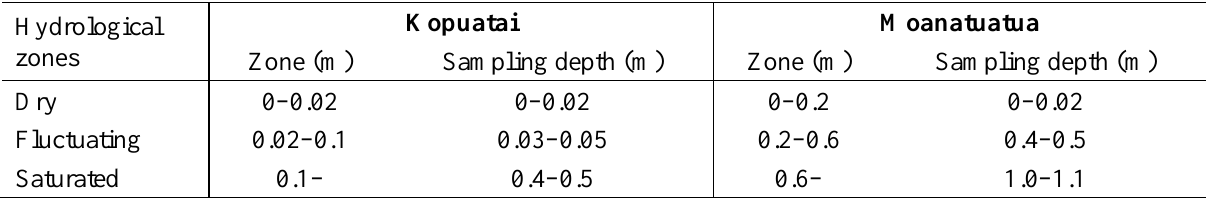
Table 1. The hydrological zones sampled at Kopuatai and Moanatuatua. ‘Zone’ indicates depth from the peat surface to the upper and lower boundaries of the